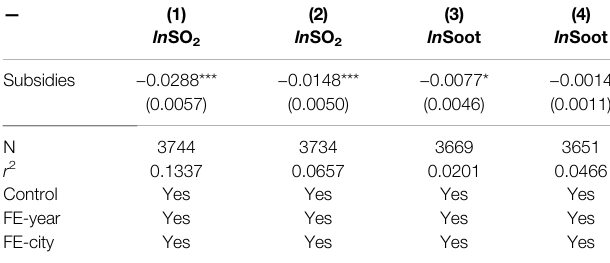
TABLE 6 | Heterogeneity of levels of economic